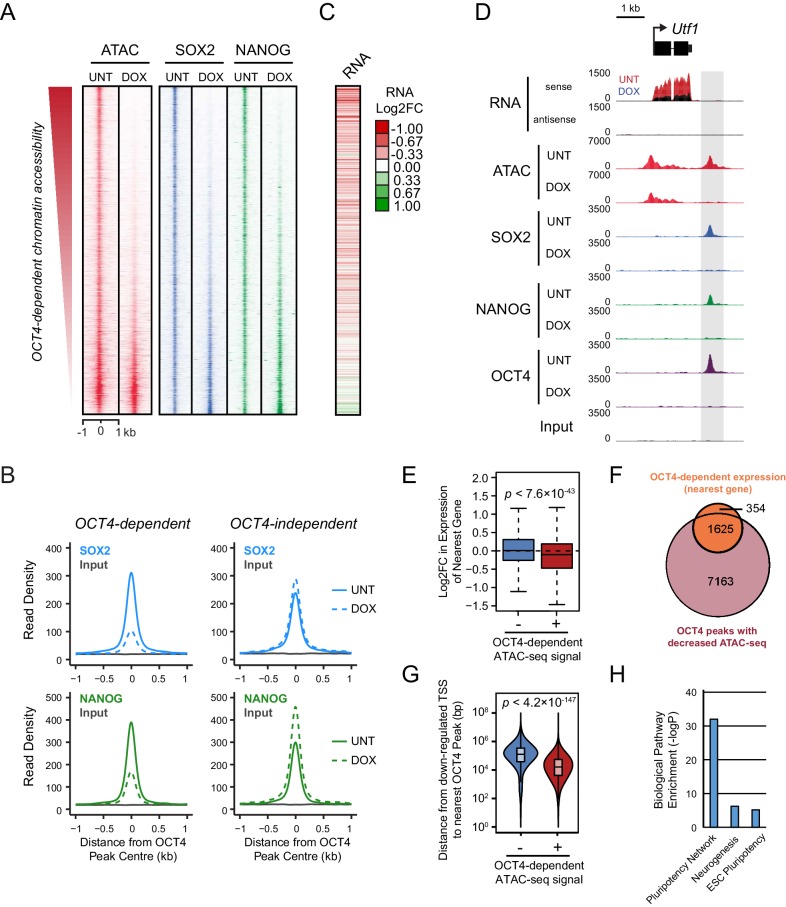
Loss of OCT4 leads to reduced pluripotency-associated transcription factor binding and expression of nearby genes.(A) A heatmap illustrating SOX2 and NANOG ChIP-seq at OCT4 targets (n = 15920) ranked by their loss of chromatin accessibility (ATAC-seq) after 24 hr DOX treatment of OCT4cond ESCs, as in Figure 1F. (B) A metaplot of OCT4cond SOX2 and NANOG ChIP-seq signal before (UNT) and after 24 hr DOX treatment at OCT4 binding sites with significant reductions in ATAC-seq signal (OCT4-dependent; n = 11557) and those without significant changes (OCT4-independent; n = 4362). (C) A heatmap of the log2 fold change in RNA-seq signal of the closest gene to OCT4 target sites depicted in (A), following 24 hr DOX treatment of the OCT4cond ESCs. (D) A genomic snapshot of Utf1, which is decreased in expression following loss of OCT4. The distal OCT4 target site is highlighted by a grey box. (E) Comparison of log2 fold change (log2FC) in RNA-seq signal for genes neighbouring OCT4 target sites that rely on OCT4 for ATAC-seq signal (OCT4-dependent; n = 11557) or those that do not (OCT4-independent; n = 4362). (F) A Venn diagram comparing the OCT4 binding sites for which the nearest gene has significantly reduced expression after OCT4 ablation (orange; n = 1979) and the OCT4 targets with significant reductions in chromatin accessibility (red; n = 8788). Only OCT4 target sites for which the nearest gene has sufficient RNA-seq coverage are included. (G) A violin plot comparing the distance from OCT4 binding sites with OCT4-dependent (n = 11557) or OCT4-independent (n = 4362) chromatin accessibility to nearest TSS with significant reductions in RNA-seq following 24 hr DOX treatment of the OCT4cond ESCs (n = 1430). (H) Gene ontology analysis for genes down-regulated after loss of OCT4 (n = 1430) reveals enrichment of the pluripotency transcriptional network.